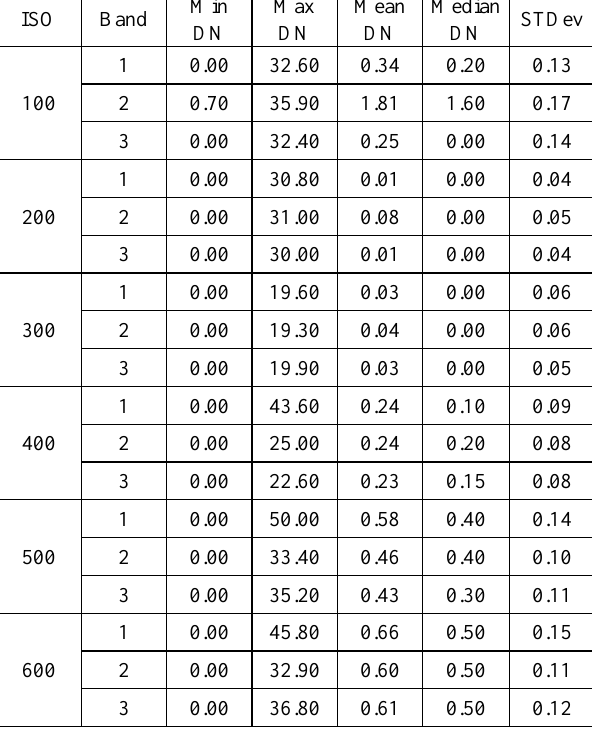
Table 3. Dark frame assessment per band for different ISO